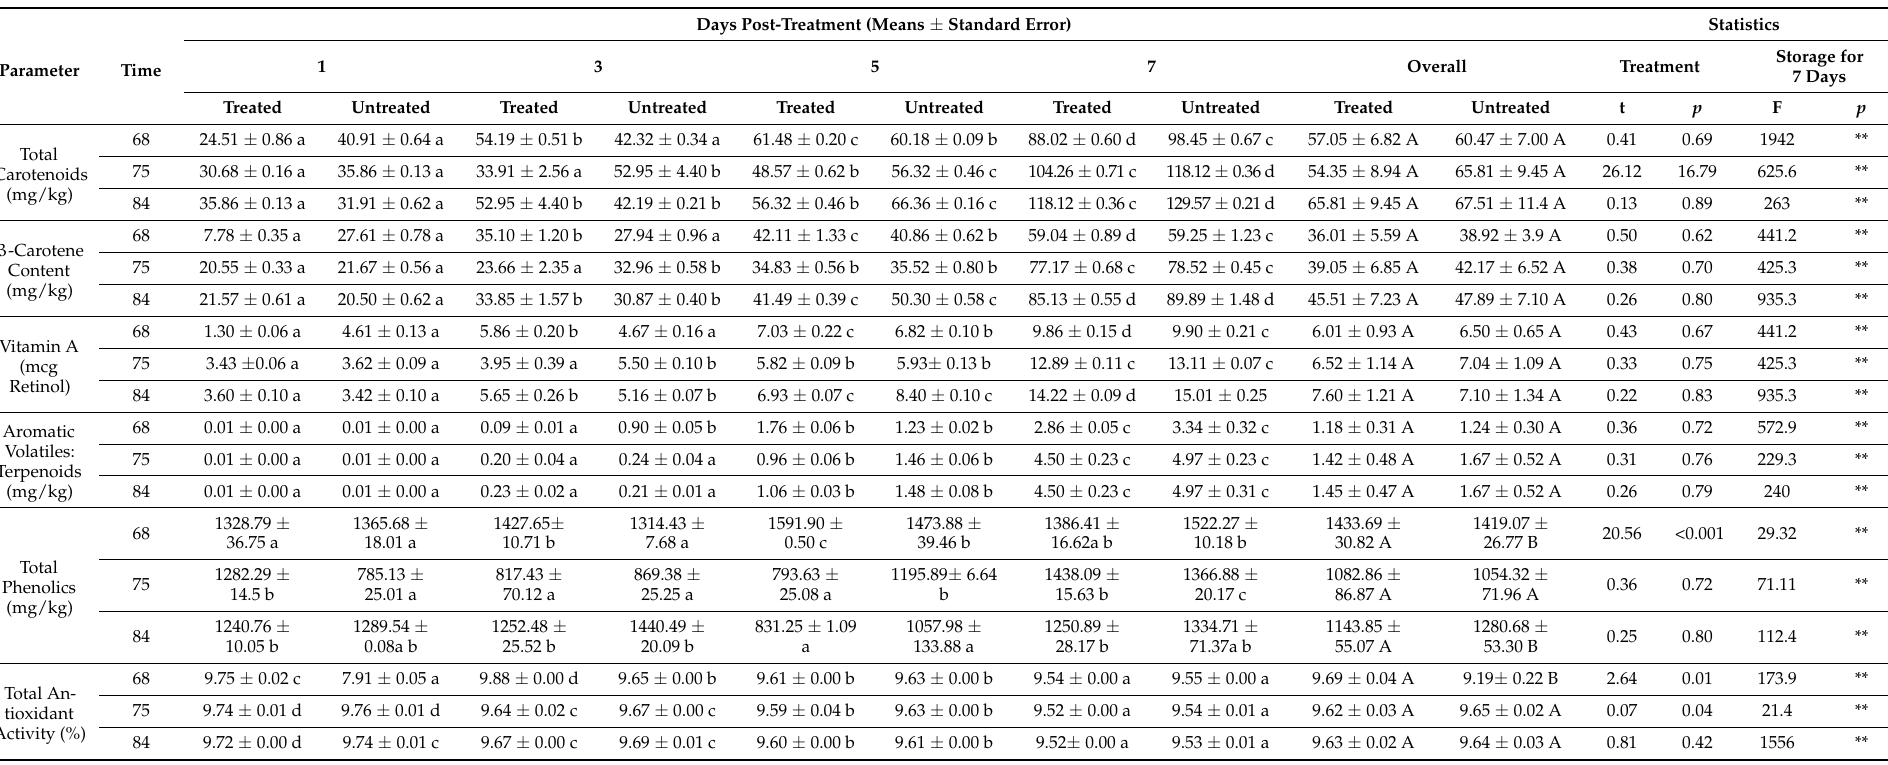
Table 3. Effect of hot water treatment at 46.1 ◦ C for different treatment durations on the dietary antioxidants of Apple mango cultivar stored over 7 days